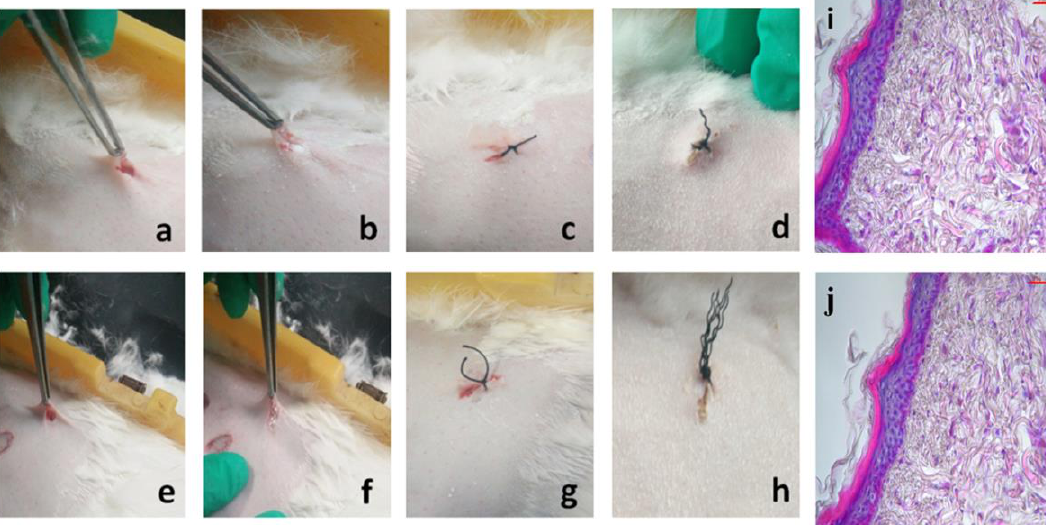
Figure 7. Biocompatibility of PBM. ( a – c ) Photograph of PBM-1 embedded subcutaneously; ( e – g ) photographs of PBM-2 embedded subcutaneously; ( d , h ) degradation subcutaneously after 3 weeks; ( i , j ) H–E staining of histological sections of subcutaneous tissue. The scale bar is 20 µ m; ( i ) PBM-1; ( j ) PBM-2.